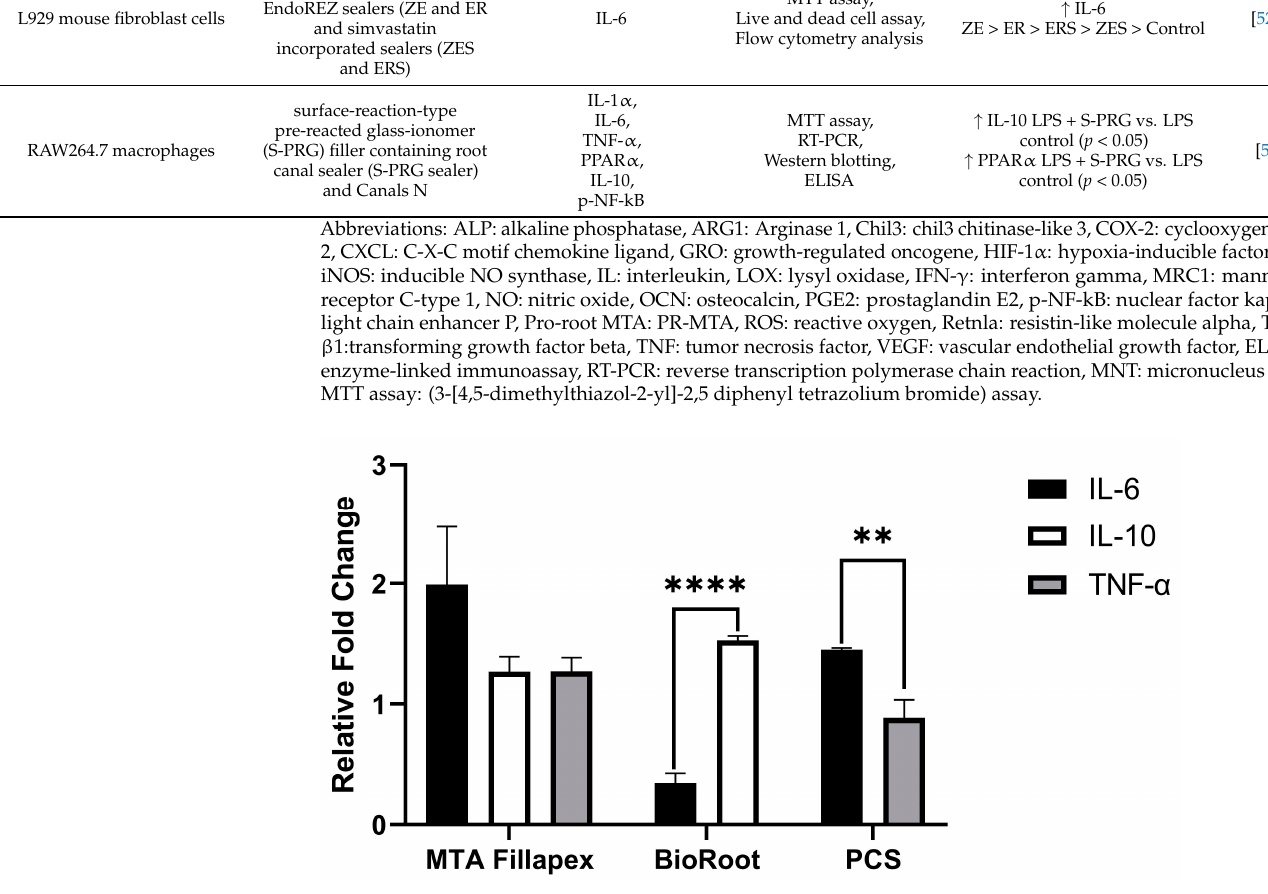
Figure 2. Relative fold change in cytokine secretion induced by different sealers. The relative fold changes in the production of IL-6 IL-10 and TNF- α were in red, yellow, and blue, respectively, based on data from [17,35,47,48]. Although MTA enhanced the production of IL-6, IL-10, and TNF- α , there were no significant difference ( p > 0.05, ANOVA multiple comparisons). The relative fold changes in IL-6 and IL-10 elicited by BioRoot RCS ( p < 0.0001, student’s t -test comparisons) and IL-6 and TNF- α ( p < 0.005, student’s t -test comparisons) induced by PCS was significant. Abbreviation: **** BioRoot (BioRoot RCS) and ** PCS (Pulp Canal